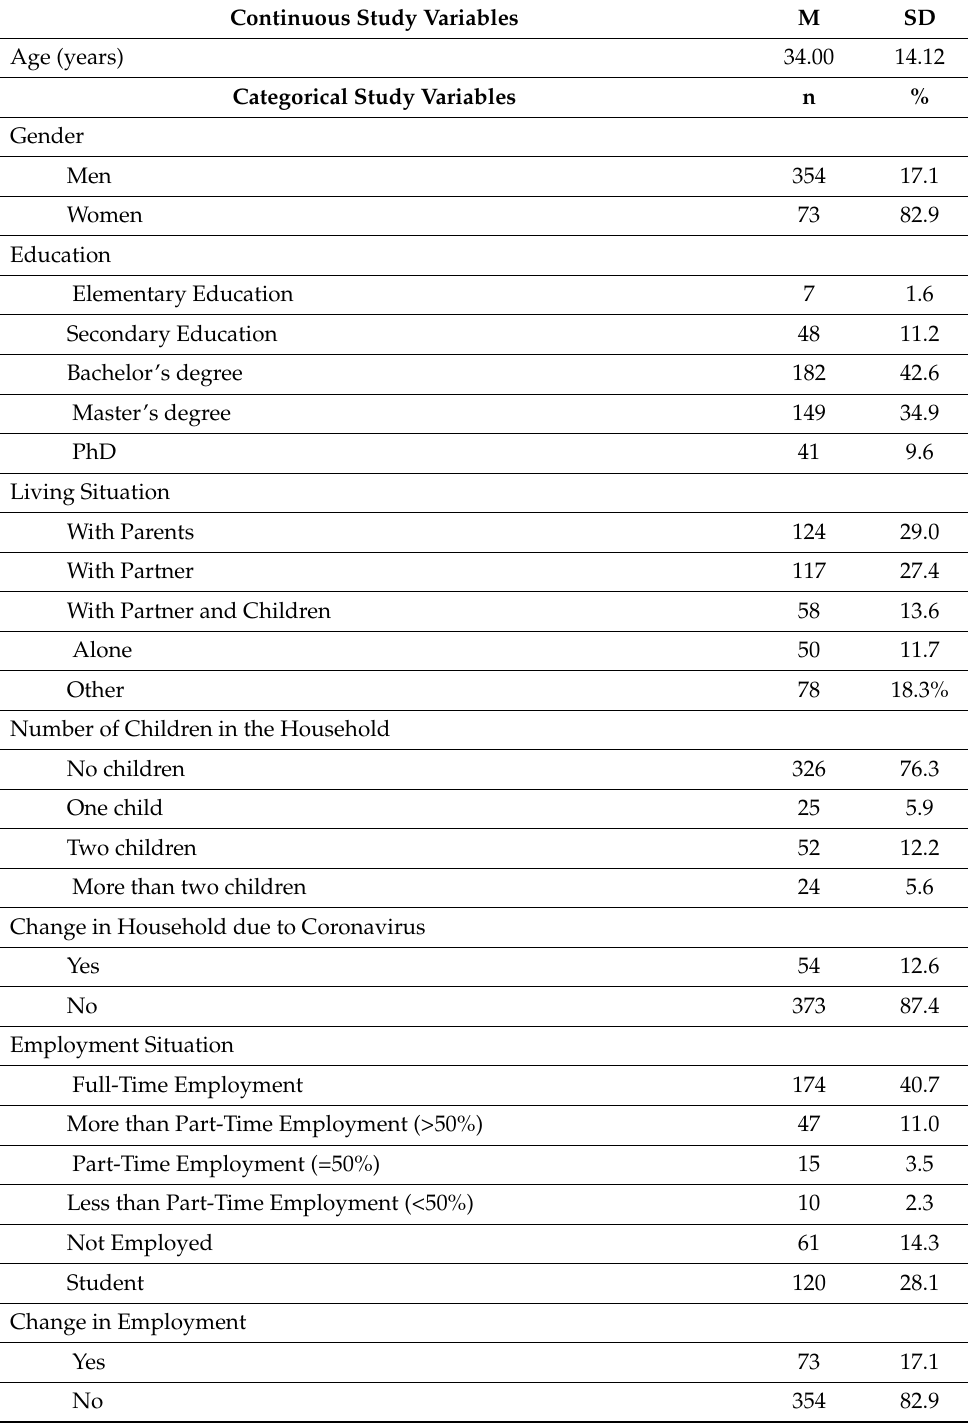
Table 1. Characteristics of